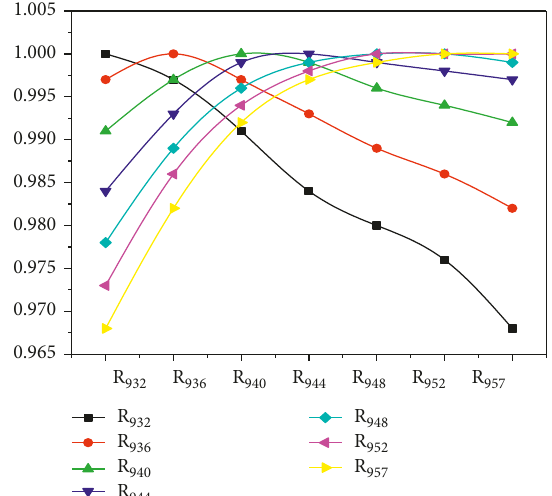
Figure 5: Correlation coefficient between gray values in the first region of the